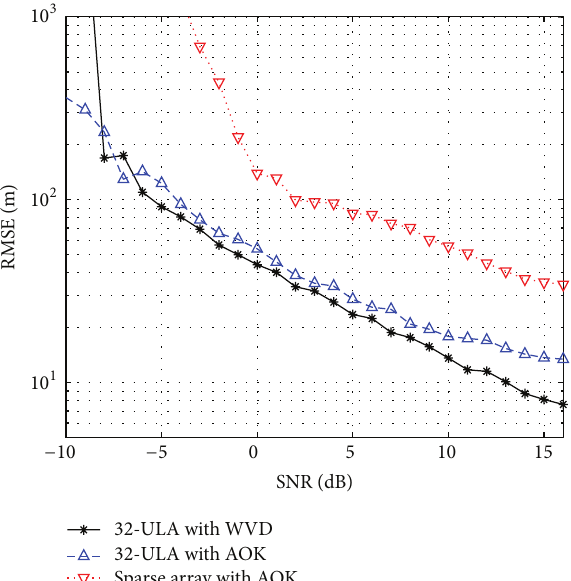
Figure 6: RMSE versus SNR ( 𝑟 1 = 1000 m, 𝜃 1 = 30 ∘ ).